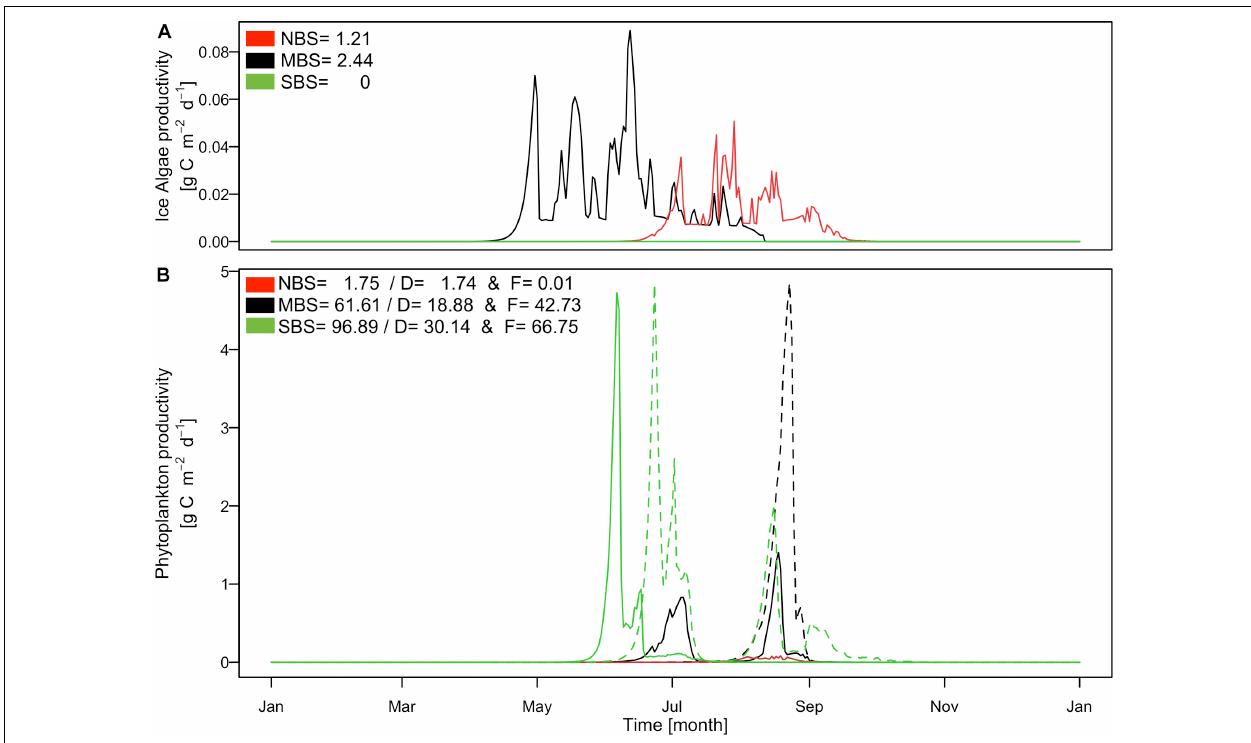
FIGURE 8 | Simulated time series of (A) production rates of ice algae; (B) production rates of phytoplankton including diatoms (D: solid line) and flagellates (F: dashed line). Black color presents result for the central Barents Sea station over the 1997, red color for the north Barents Sea station over the 1997, and green color for the south Barents Sea station over the 1997. In the legend (A,B) are indicated the annual production in gC m − 2 for ice algae and phytoplankton including diatoms production (D) and flagellates production